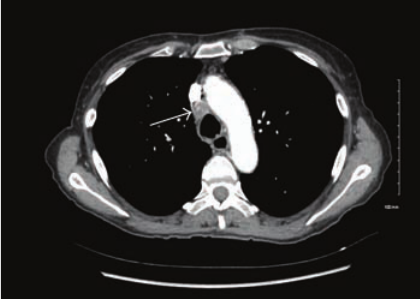
Figure1:CTscanofthethoraxdemonstratingnecroticparatracheal node. Enhanced axial CT scan of the thorax, mediastinal window, in a 58-year-old female who presented with bilateral vocal cord immobility of unknown etiology. The positive serum anti-Hu antibody, which is highly associated with small cell lung carcinoma, led to this repeat CT scan. The arrow demonstrates an enlarged level 4R paratracheal lymph node with central necrosis. See Figure 2 for the pathologic description of a biopsy from this